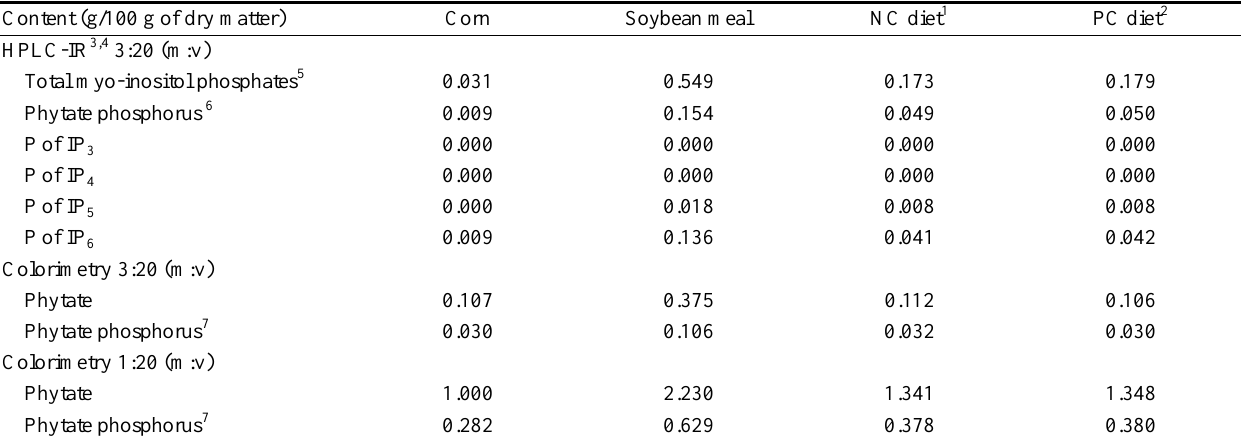
Table 2. Contents of phytate and phytate phosphorus in ingredients and diets, determined according to two analytical methodologies and extraction ratios Content (g/100 g of dry matter)